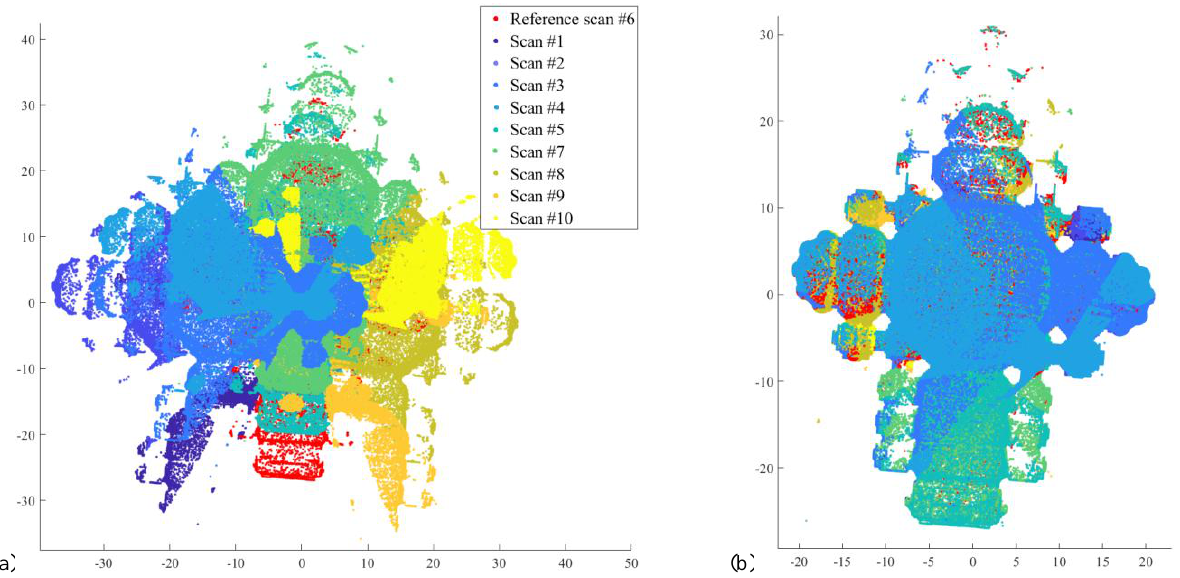
Figure 4. Top view of the ten unorganized point clouds before registration (a) and after registration (b) using MORPH ε D